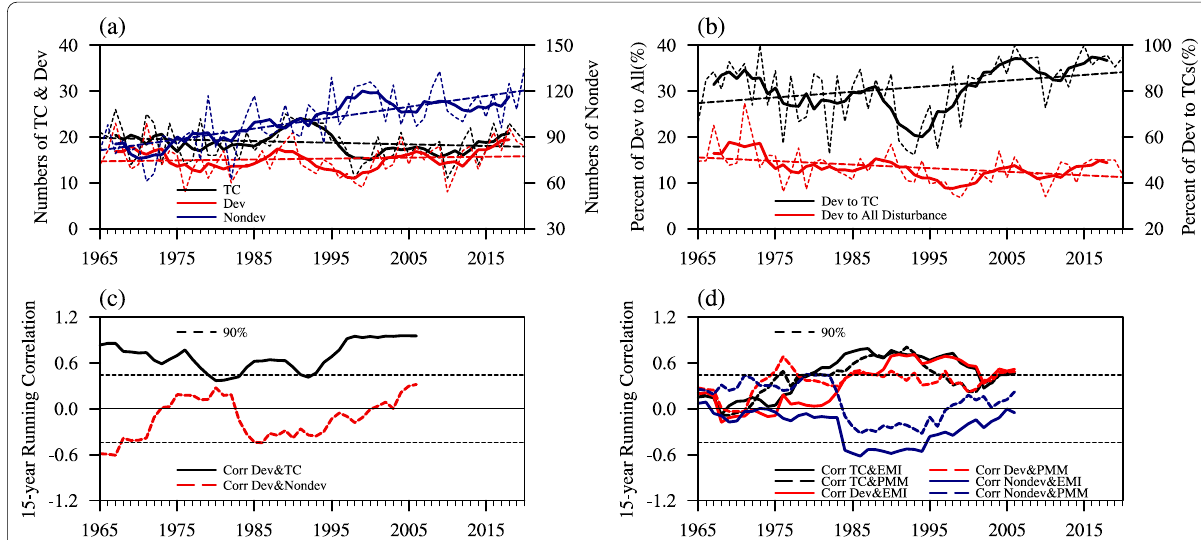
Fig. 5 a The annual genesis frequency of developing (red line) and nondeveloping (blue line) disturbances and TCs (black line) over the WNP. The solid lines ( a , b ) are the 5-year running mean, and the dashed lines ( a , b ) are the least-squares best-fit line trends. b The percentage of developing disturbances to all tropical disturbances (red lines), developing disturbances to TCs (black lines). c The time series of 15-year running correlation of developing disturbances to TCs (solid black line), nondeveloping disturbances to developing disturbances (red dotted line). d The 15-year running correlation of EMI and PMM indices to TCs (black lines), developing (red lines), and nondeveloping (blue lines) disturbances. The black dashed lines indicae the lines of the 90% confidence level